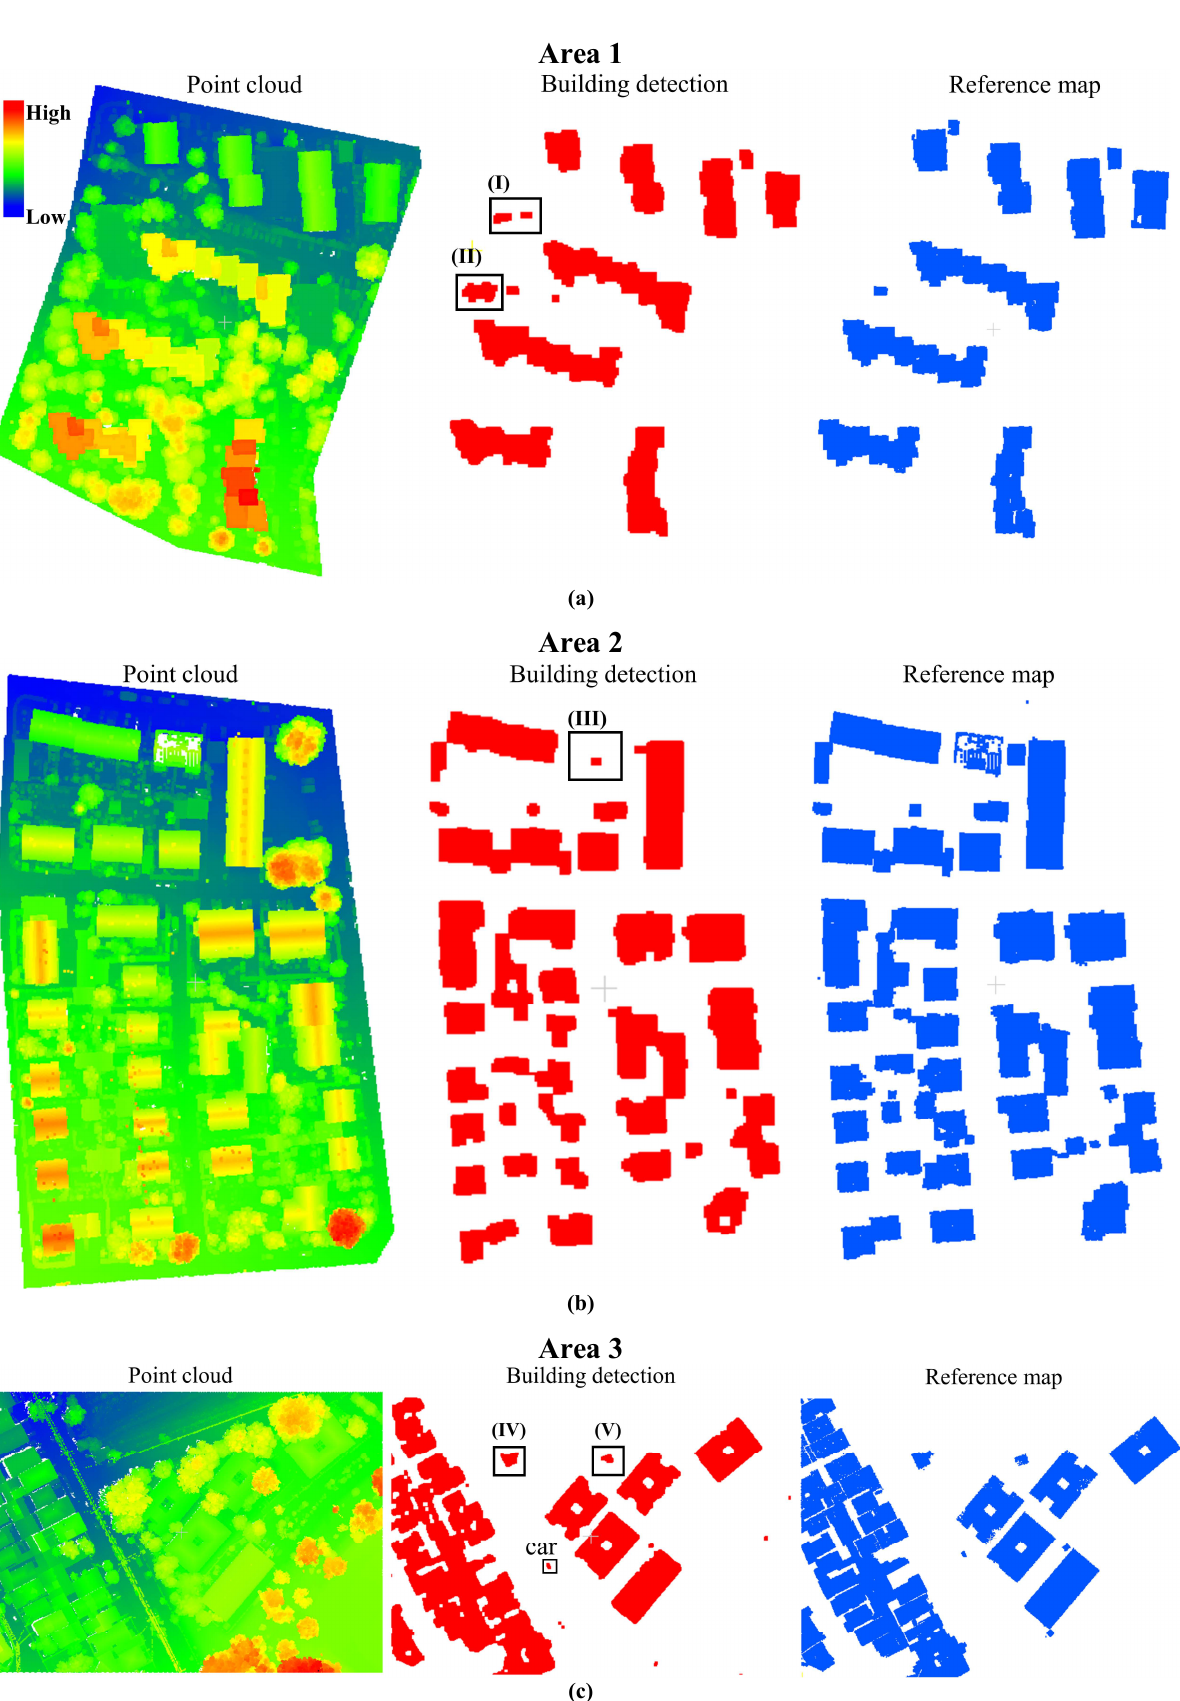
Figure 5. Building detection using the proposed method for the study areas 1 (a), 2 (b) and 3 (b). Point cloud according to height (left column), result derived from proposed method (middle column) and reference map (right